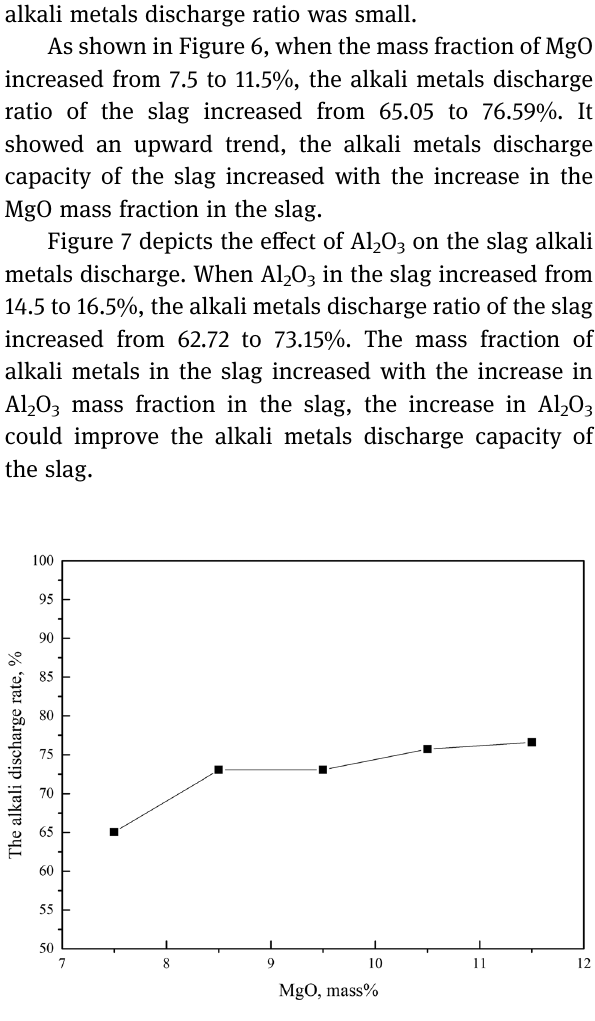
Figure 8: E ff ect of MnO on slag alkali metals